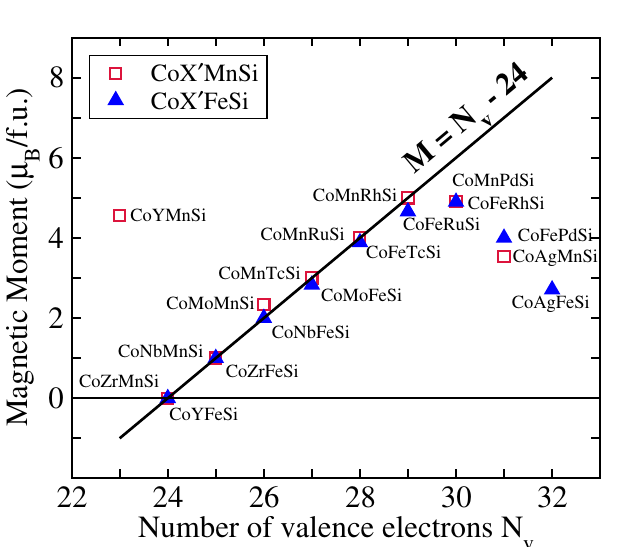
Figure 2. Schematic representation of preferred ground state structures (Red - Type-I; Green - Type-II) of CoX ′ Y ′ Si compounds. The number attached to each element represent it’s electronegativity (Pauli scale).